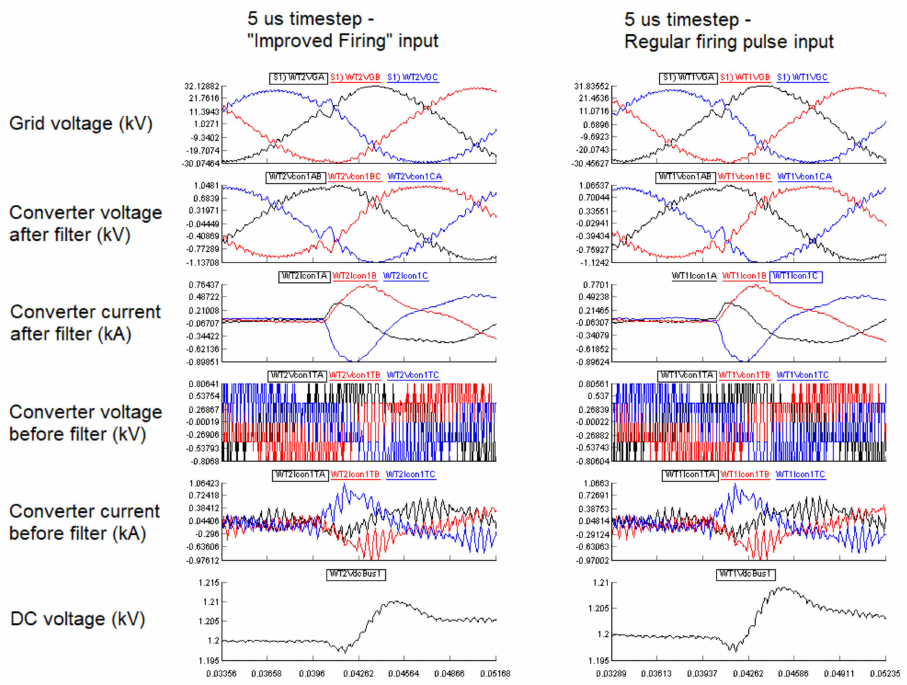
Figure 1. Simulation results for two different input modes of the universal converter model (“Im- proved Firing”, left; regular firing pulse, right), running at 5 microseconds in a two-level STATCOM application. Event shown is an AC reference voltage change from 1.0 to 1.1 pu.